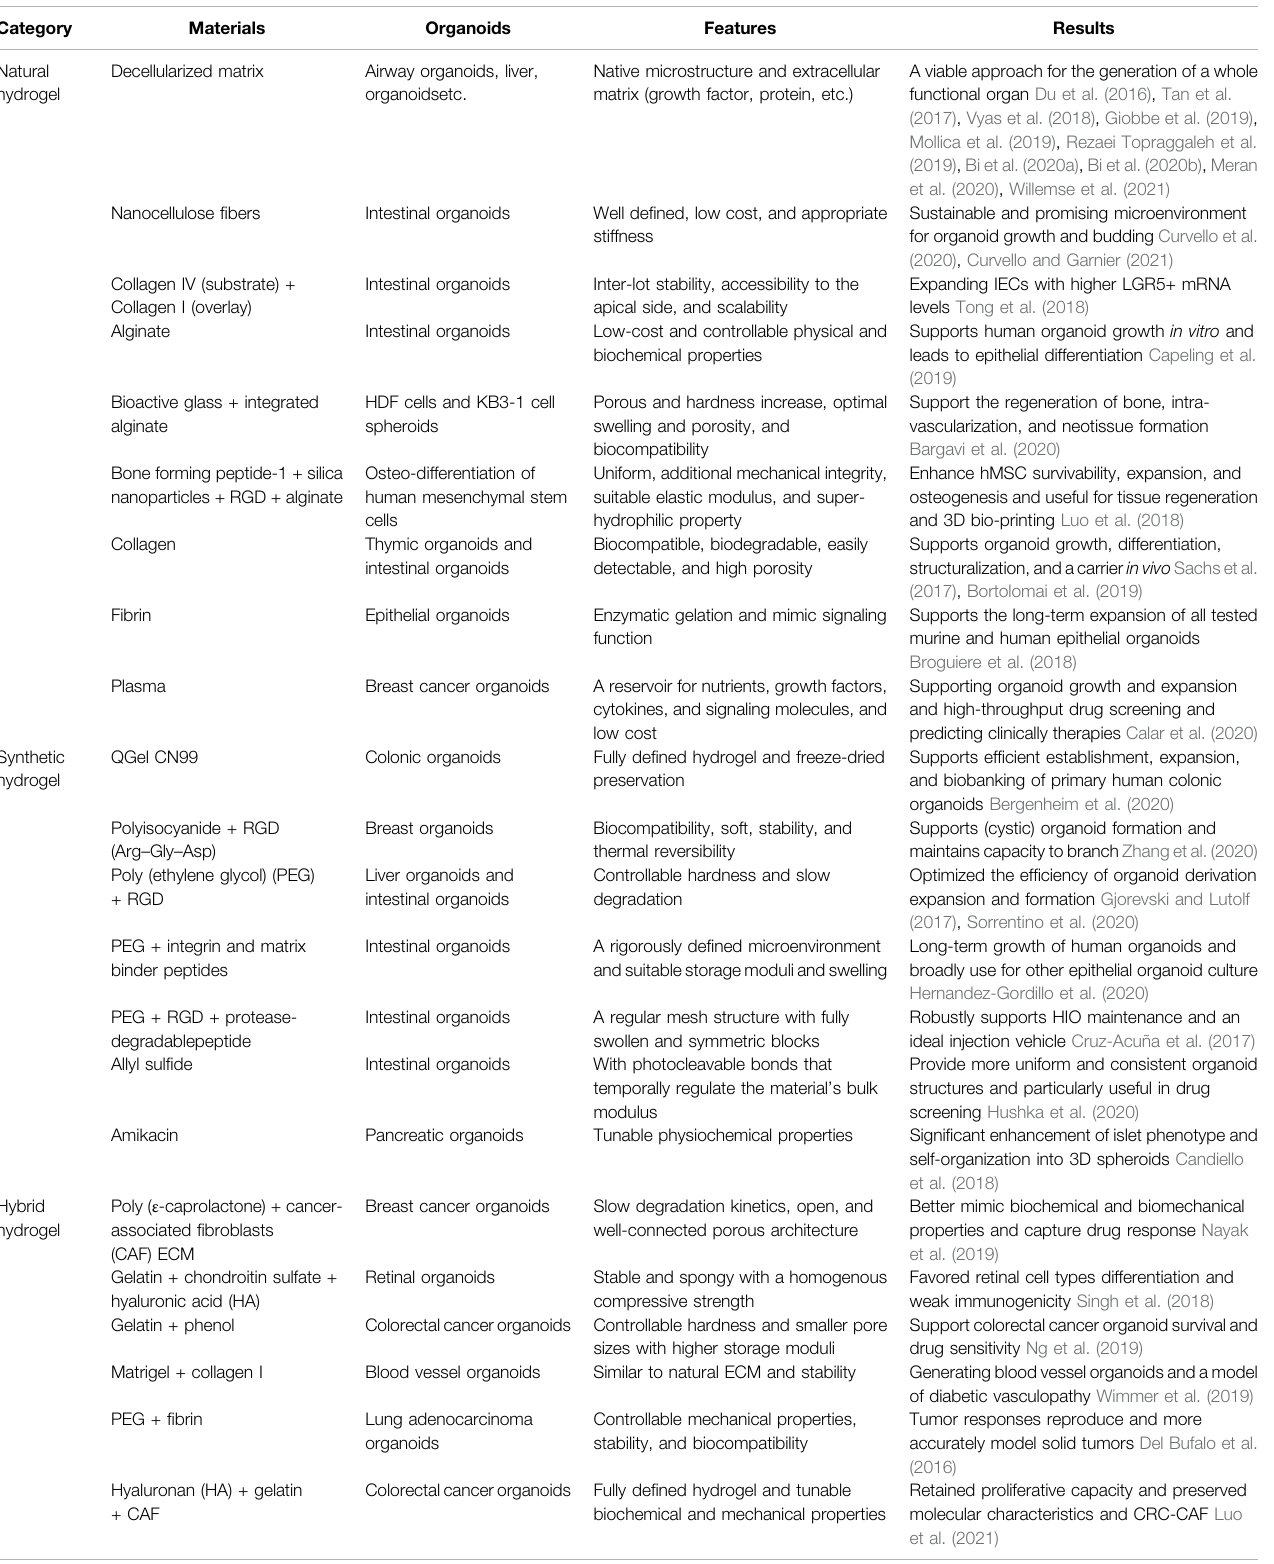
TABLE 5 | Organoids and